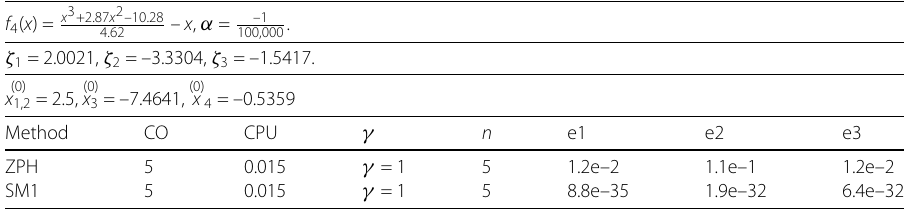
Table 3 Simultaneous finding of all roots of f 4 ( x ) f 4 ( x ) = x 3+2.87 x 2–10.28 – x , α = –1 4.62 100,000